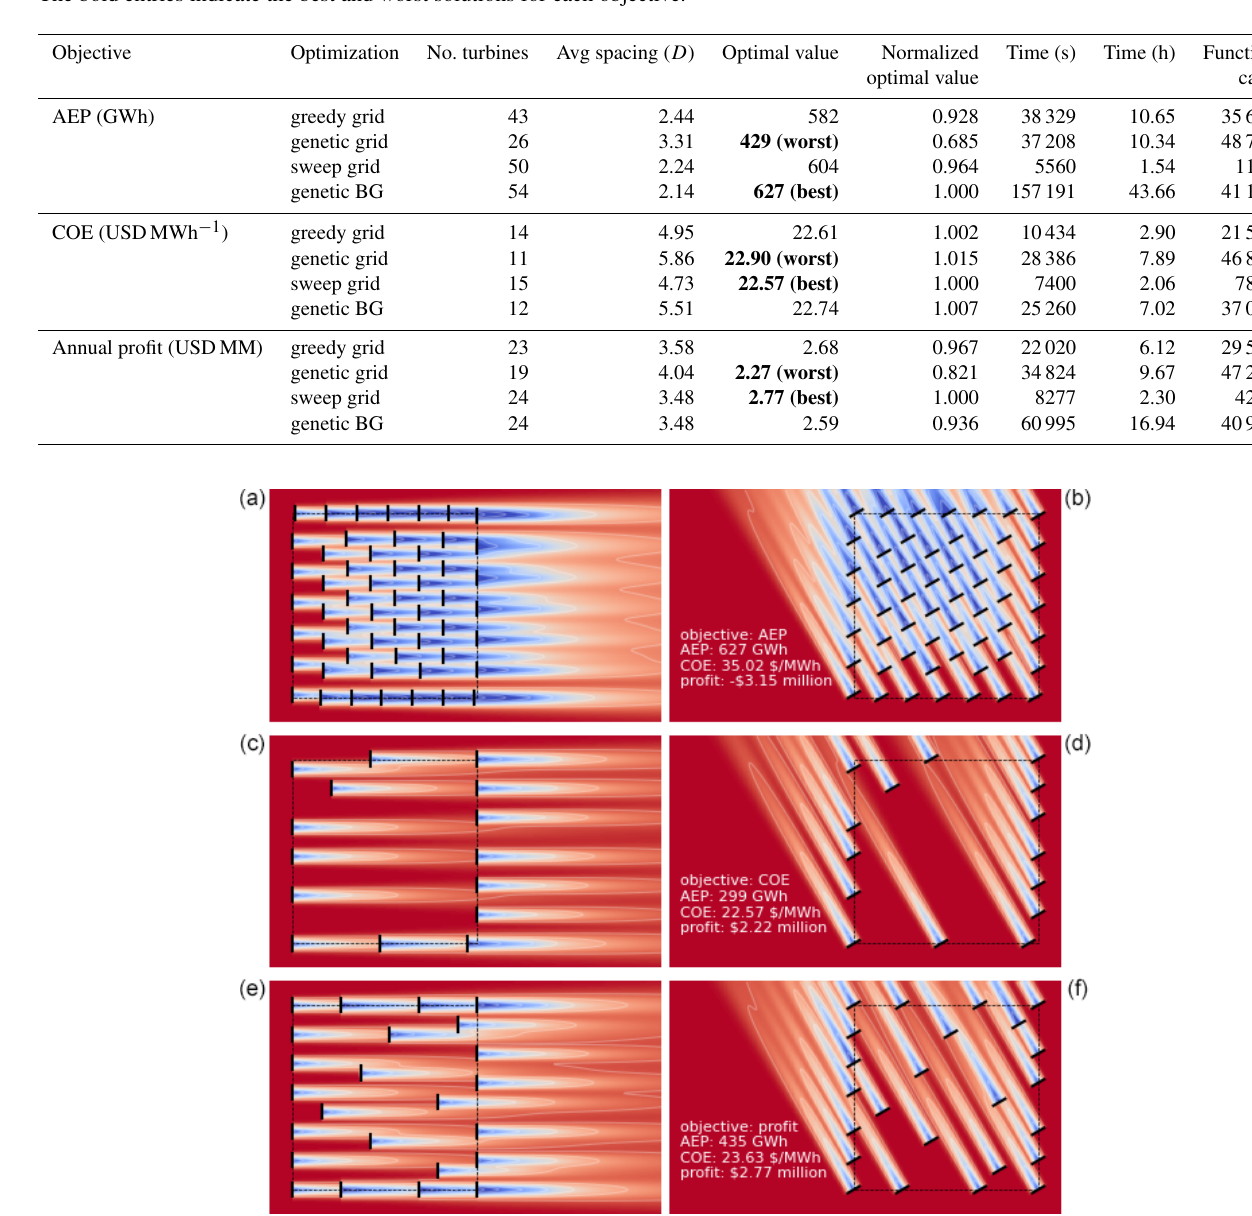
Table 4. Complete optimization results for the large wind power plant with full wind rose. “BG” indicates the boundary-grid design variables. The bold entries indicate the best and worst solutions for each objective.